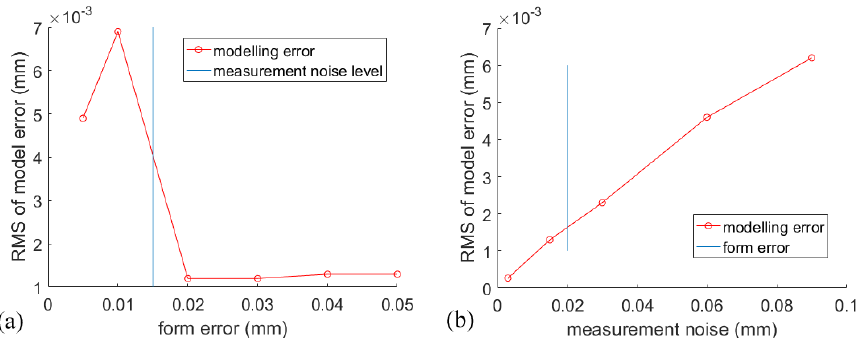
Figure 15. The relationship between model error, form error and measurement noise: ( a ) when measurement noise is fixed; and ( b ) when form error is fixed.